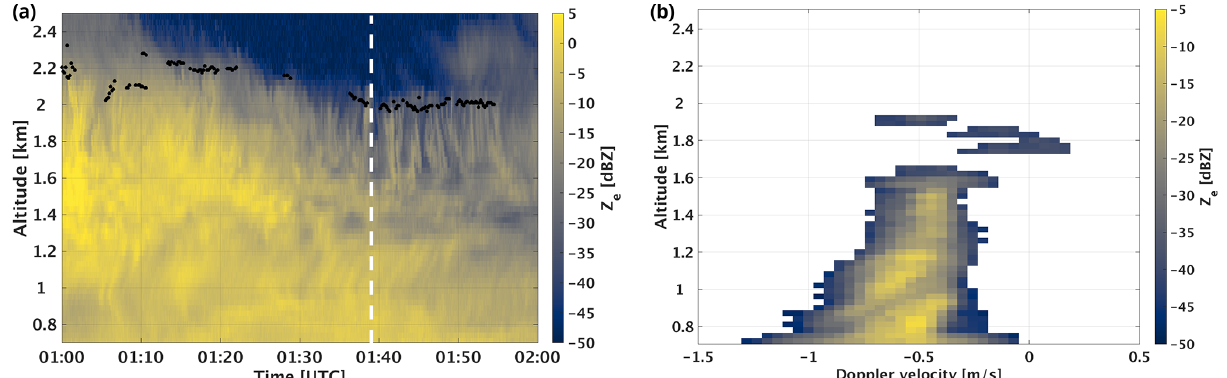
Figure D2. (a) KAZR MD mode Z e over the NSA on 19 January 2015 between 01:00 and 02:00UTC. Black dots designate the HSRL liquid cloud base height data product. (b) KAZR GE spectra profile at 01:39:02UTC (designated by the dashed white line in the left panel).